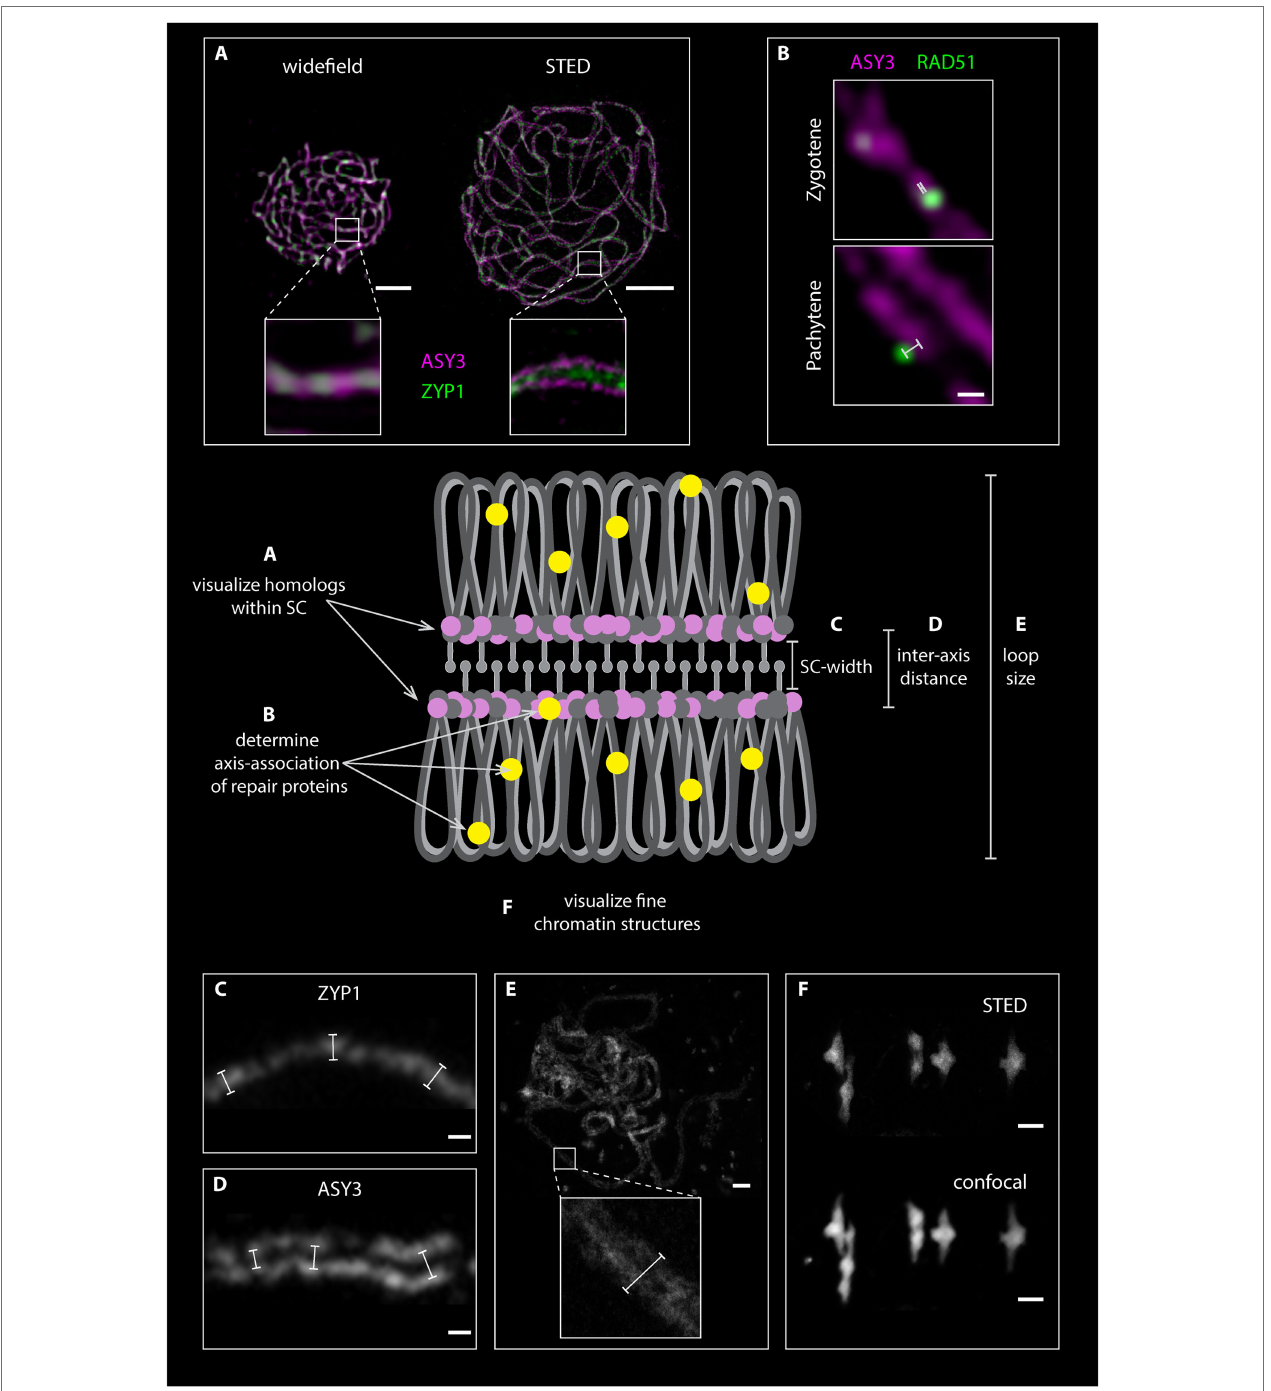
FIGURE 4 | Graphical representation of homologous chromosomes with a fully formed synaptonemal complex (SC). The loops of the homologous chromosomes are depicted in gray, the axial elements in pink and dark gray, the SC transverse filaments in light gray and repair proteins in yellow. Chromosomal features, which can be assessed by STED nanoscopy, are highlighted. (A) . Comparison between widefield and STED images of detergent-spread male meiotic nuclei, which were stained for the axis (ASY3) in magenta and the transverse filament (ZYP1) in green. (B) . Magnification of meiotic chromosomes in zygotene and pachytene stage stained for ASY3 (magenta) and the recombinase RAD51 (green). White bars indicate the distance measurements of each focus from the center for the axis. (C) and (D) Examples of measurements of SC width and inter-axis distance in nuclei stained for ZYP1 (C) and ASY3 (D) . (E) Measurement of DNA loop length on an acid spread pachytene nucleus. (F) . Comparison between STED and confocal microscopy of an acid-spread nucleus at metaphase I stained with SYBR green (confocal) and SiR DNA (STED). Scale Bars: (A,E,F) 2 μ m; (B,C,D) 100